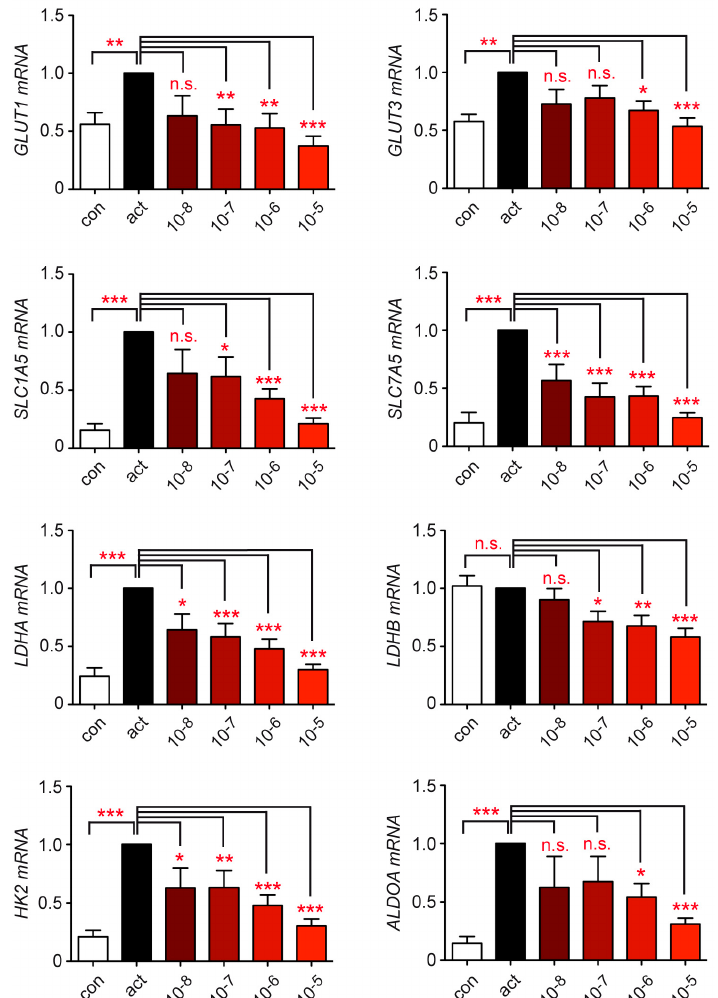
Figure 4. Repression of metabolic genes in human peripheral blood T cells by Dex treatment in vitro. T cells were purified from buffy coats of healthy human donors and stimulated with hCD3 ε and hCD28 antibodies for 20 h in the absence (act) or presence of 10 − 8 to 10 − 5 M Dex. Unstimulated T cells served as a control (con). Gene expression was determined by RT-qPCR. N = 9–12. Relative mRNA levels were calculated by normalization to the housekeeping gene 18SRNA . Expression in activated T cells was arbitrarily set to 1. Values are depicted as the mean ± SEM. Statistical analysis was performed by one-way ANOVA followed by a multiple comparisons test. Levels of significance: ∗ p < 0.05; ∗∗ p < 0.01; ∗∗∗ p < 0.001; n.s.: p > 0.05.